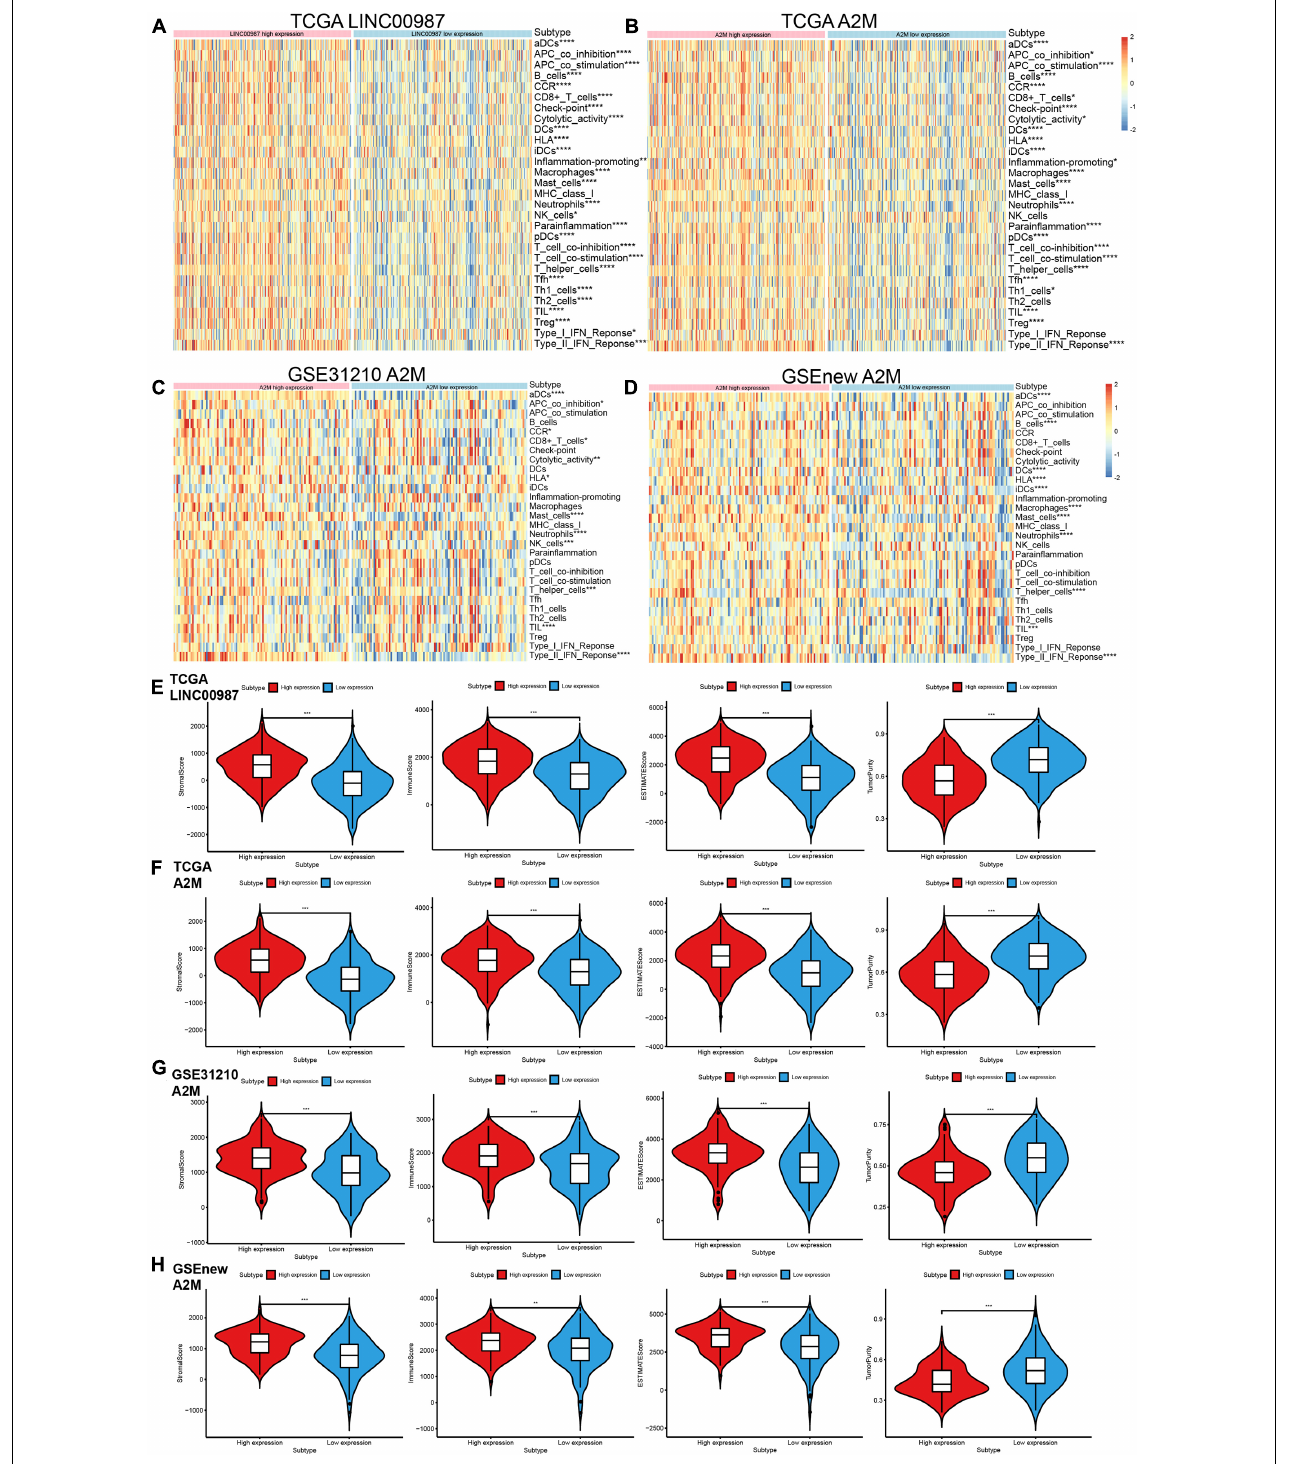
FIGURE 4 | Distribution of immune-related characteristics in different subgroups related to LINC00987 and A2M in the TCGA and GEO datasets. (A,B) Heatmap of the expression of LINC00987 and A2M and 29 immune-related gene sets generated by ssGSEA in TCGA cohort. (C,D) Heatmap of the expression of A2M and 29 immune-related gene sets generated by ssGSEA in two GEO cohorts. Violin-plot showing the difference in ImmuneScore, StromalScore, ESTIMATEScore, and TumorPurity in (E) LINC00987 and (F–H) A2M subgroups in TCGA and GEO cohorts. * p < 0.05, ** p < 0.01, *** p < 0.001, and **** p < 0.0001.